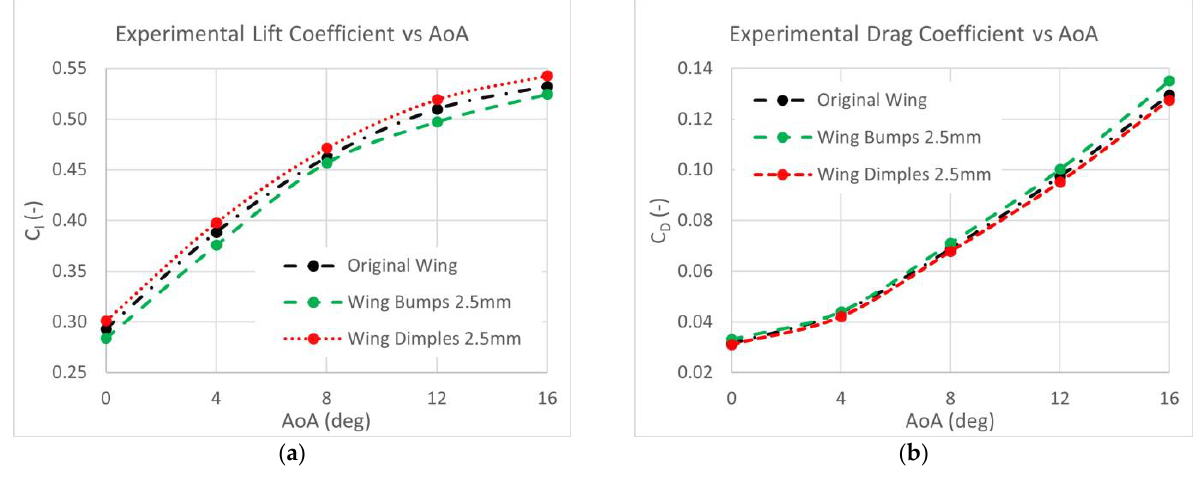
Figure 19. Experimental coefficients ( a ) of lift and ( b ) of drag for the three wing configurations.